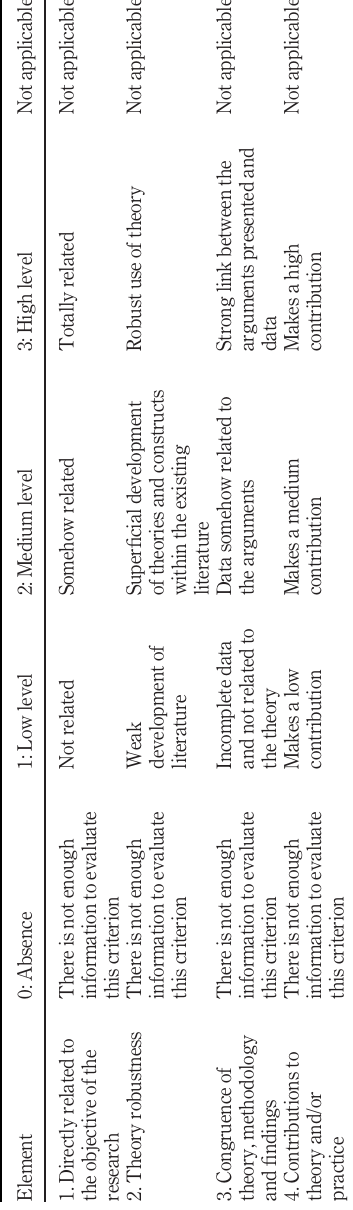
Table A1. Quality